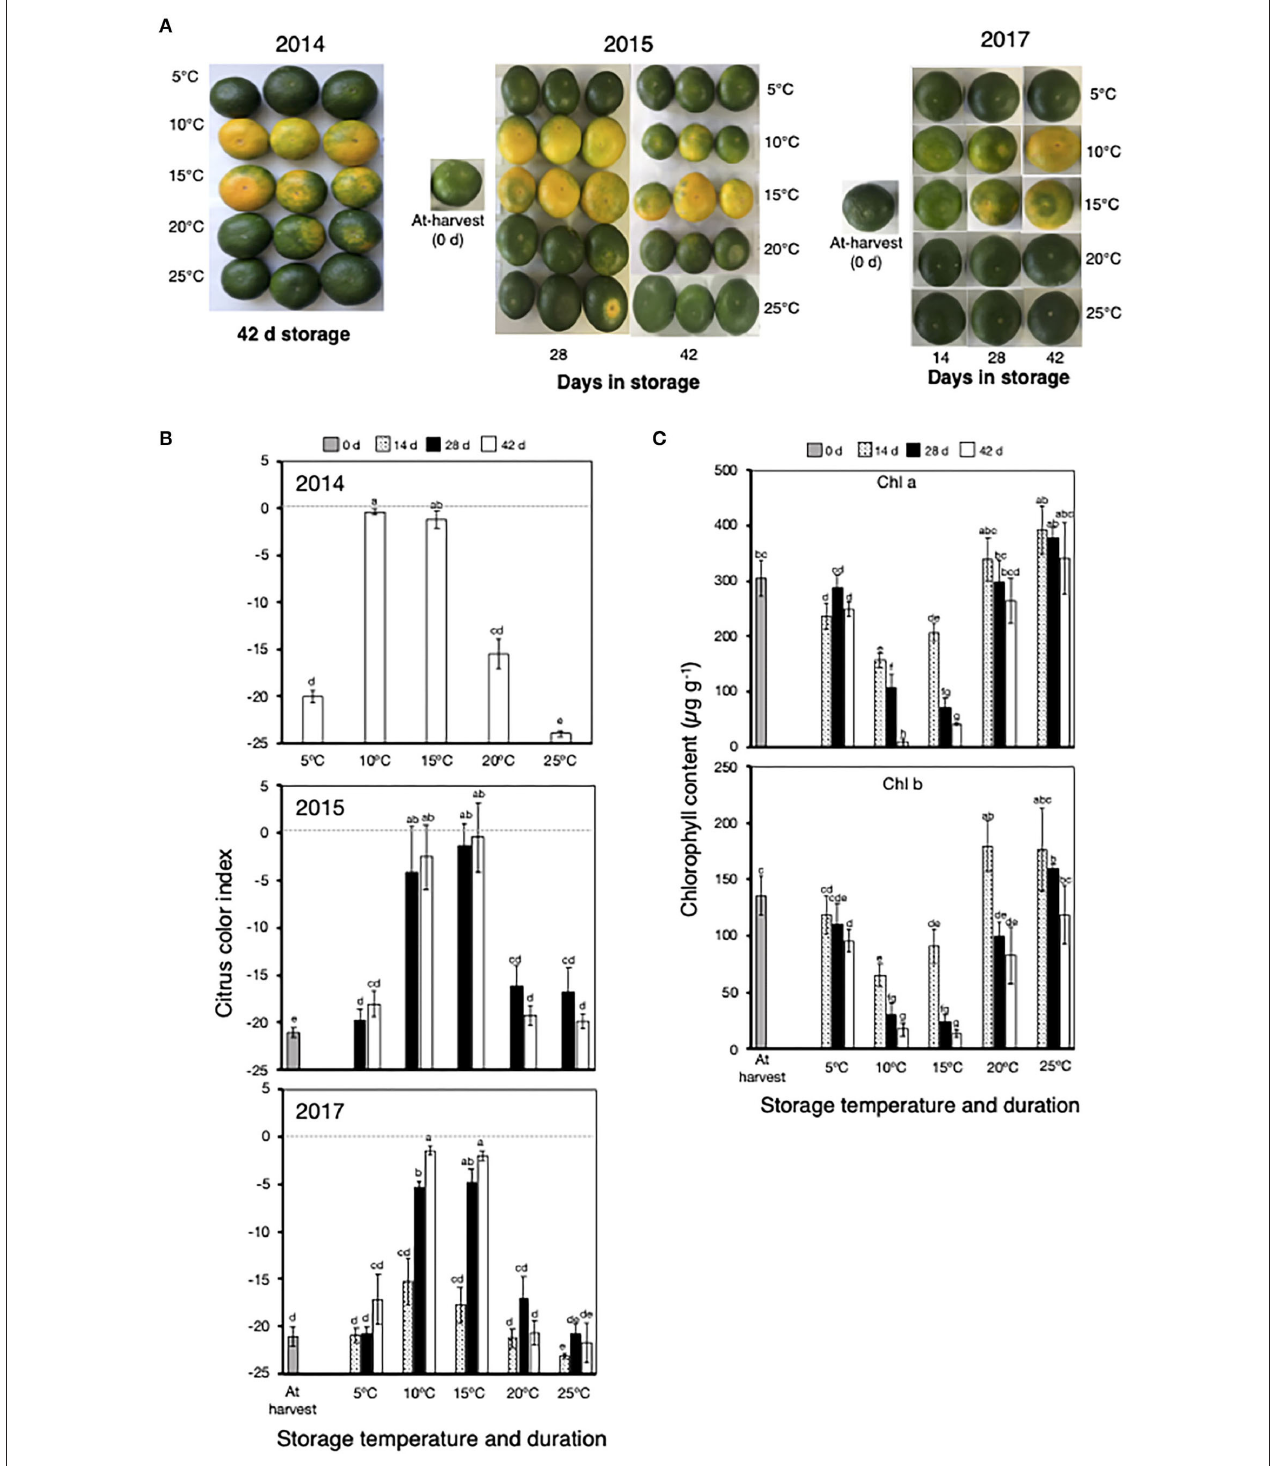
FIGURE 2 | Peel degreening behavior of Satsuma mandarin fruit at different storage temperatures. (A) Appearance of fruit during and after storage at different temperatures. (B) Changes in citrus color index during and after storage at different temperatures. Dashed line indicates color index 0, which represents a color change from green to yellow/orange. (C) Changes in peel chlorophyll content during storage at different storage temperatures. Samples for chlorophyll content determination were collected in 2017. Each data point represents the mean ( ± SE) of six replicate fruit. Different letters indicate significant differences in ANOVA (Tukey’s test, P <